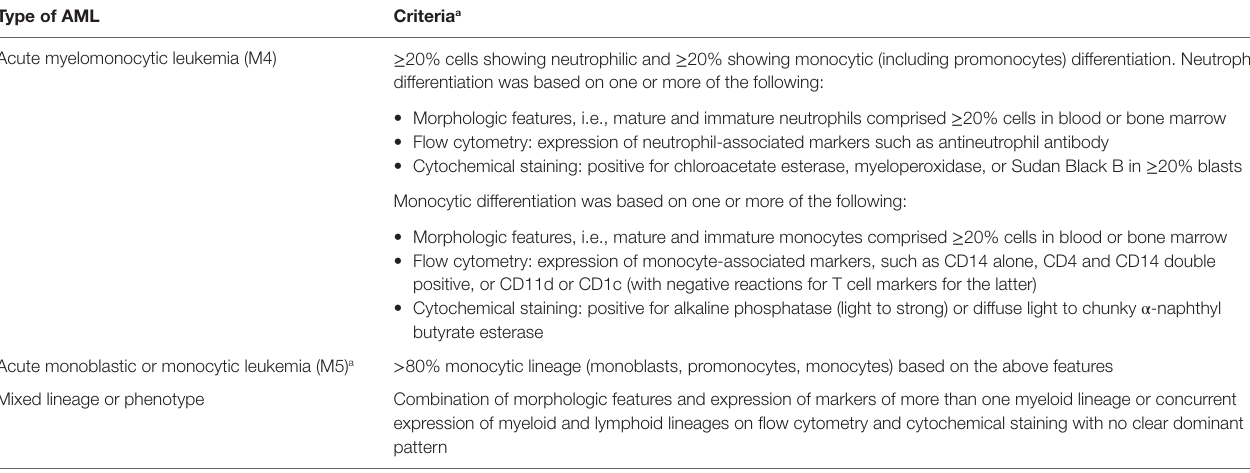
TaBle 2 | criteria used for classification of the subtype of acute myeloid leukemia (aMl) based on the World health Organization scheme of aMl – not otherwise specified (17, 18). Type of